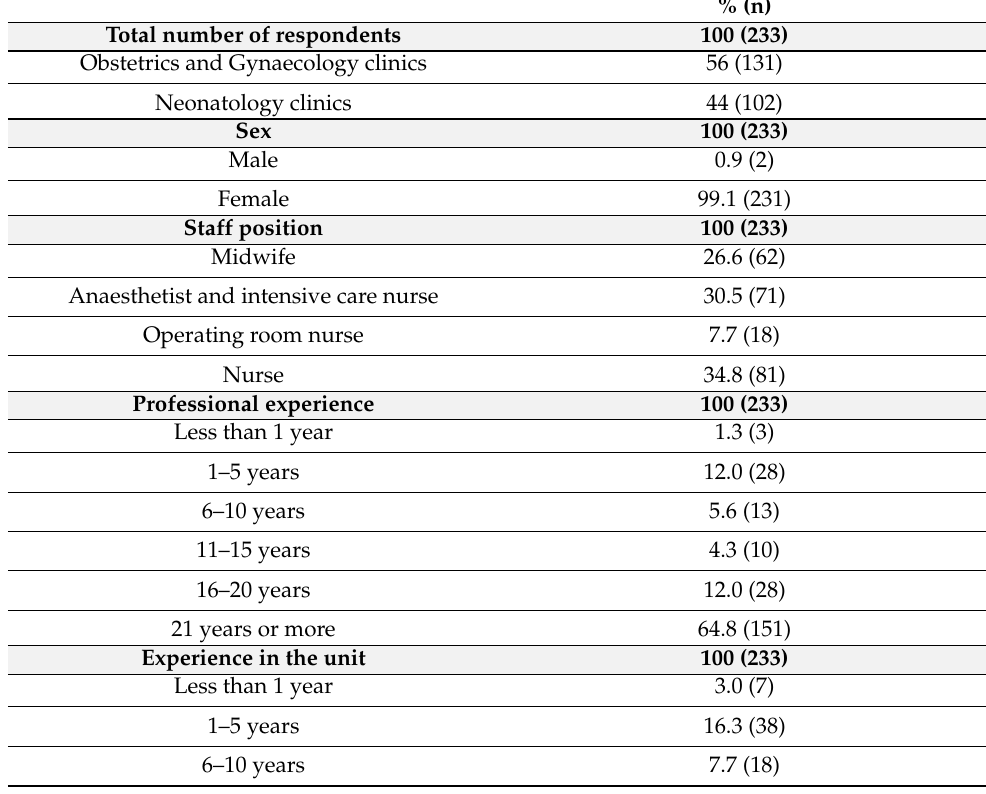
Table 2. Respondents’